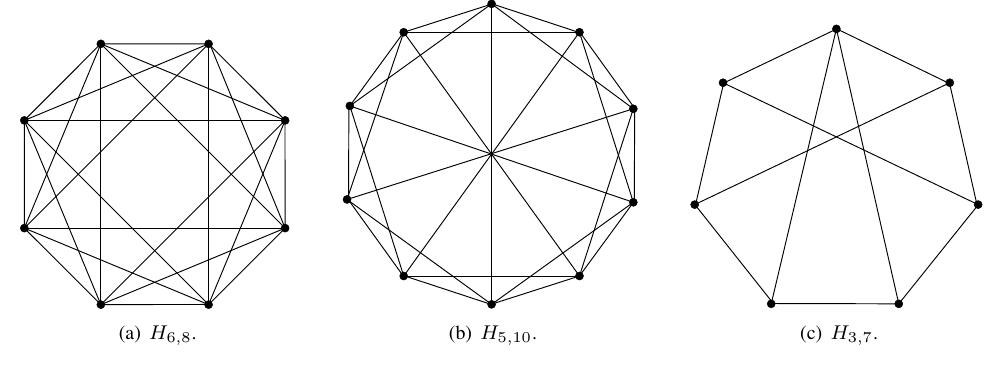
Fig. 1: Three examples of Harary